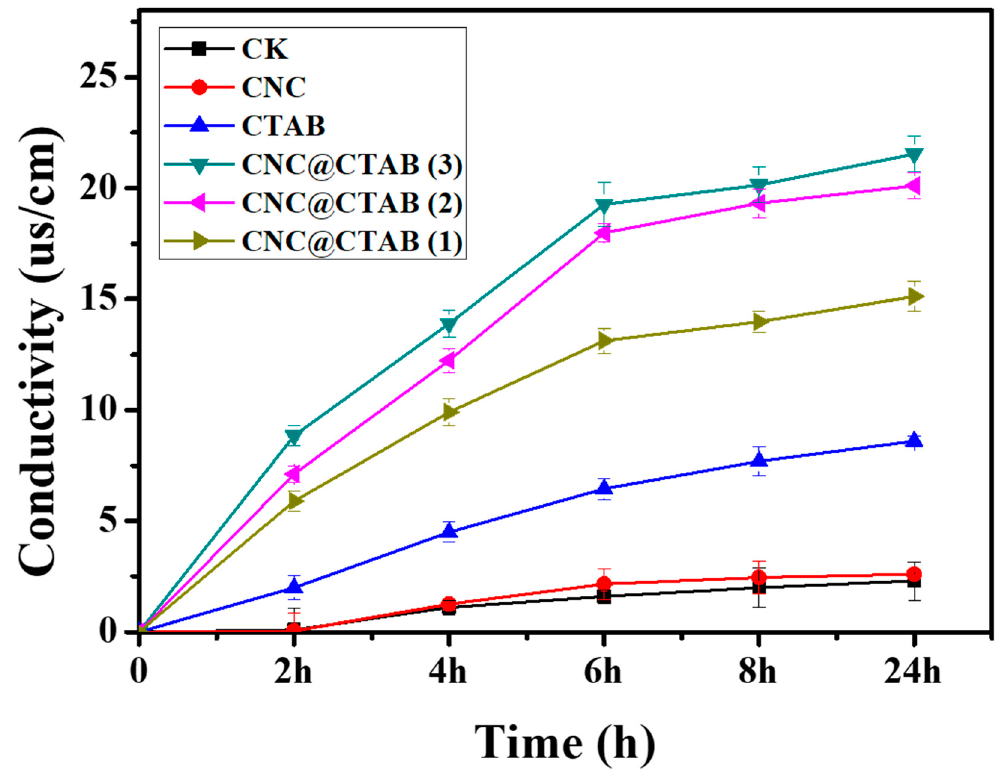
Figure 3. Curve of the extracellular fluid conductivity of Phytophthora capsici with time after adding CNC, CTAB, and CNC@CTAB (with different CTAB densities). CNC@CTAB (3) means that the CTAB density on the CNC surface is 5.50 × 10 − 2 nmol/cm 2 . CNC@CTAB (2) means that the CTAB density on the CNC surface is 3.96 × 10 − 2 nmol/cm 2 . CNC@CTAB (1) means that the CTAB density on the CNC surface is 2.86 × 10 − 2 nmol/cm 2 . The CNC is the cellulose nanocrystal. CTAB is the hexadecyltrimethylammonium bromide. Control group (CK) is the water group. Vertical bars indicate standard deviations ( n = 3) ± S.E.